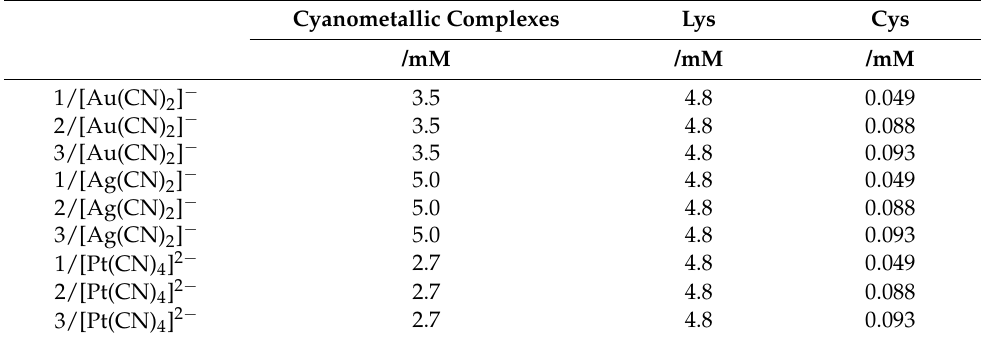
Table 1. Calculated concentrations of potassium cyanometallate complexes and of repeating units in diblock copolypeptide amphiphiles in aqueous solutions prepared at a 1:1 mass ratio (that is: 1 mg to 1 mg in 1 mL of water).